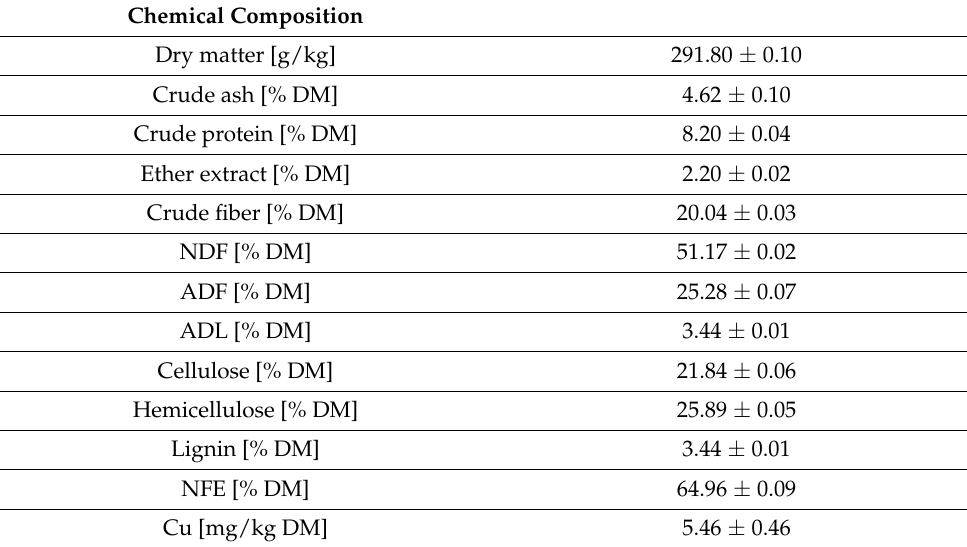
Table 1. Chemical composition of the total mixed ration (mean ± sd). Chemical